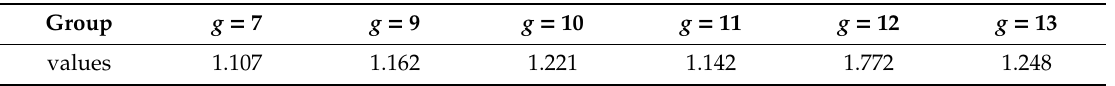
(cid:17) (cid:16) N 2,1 , ν g , g = 1, ... ,30 with absolute values greater than 1.0. k = 1